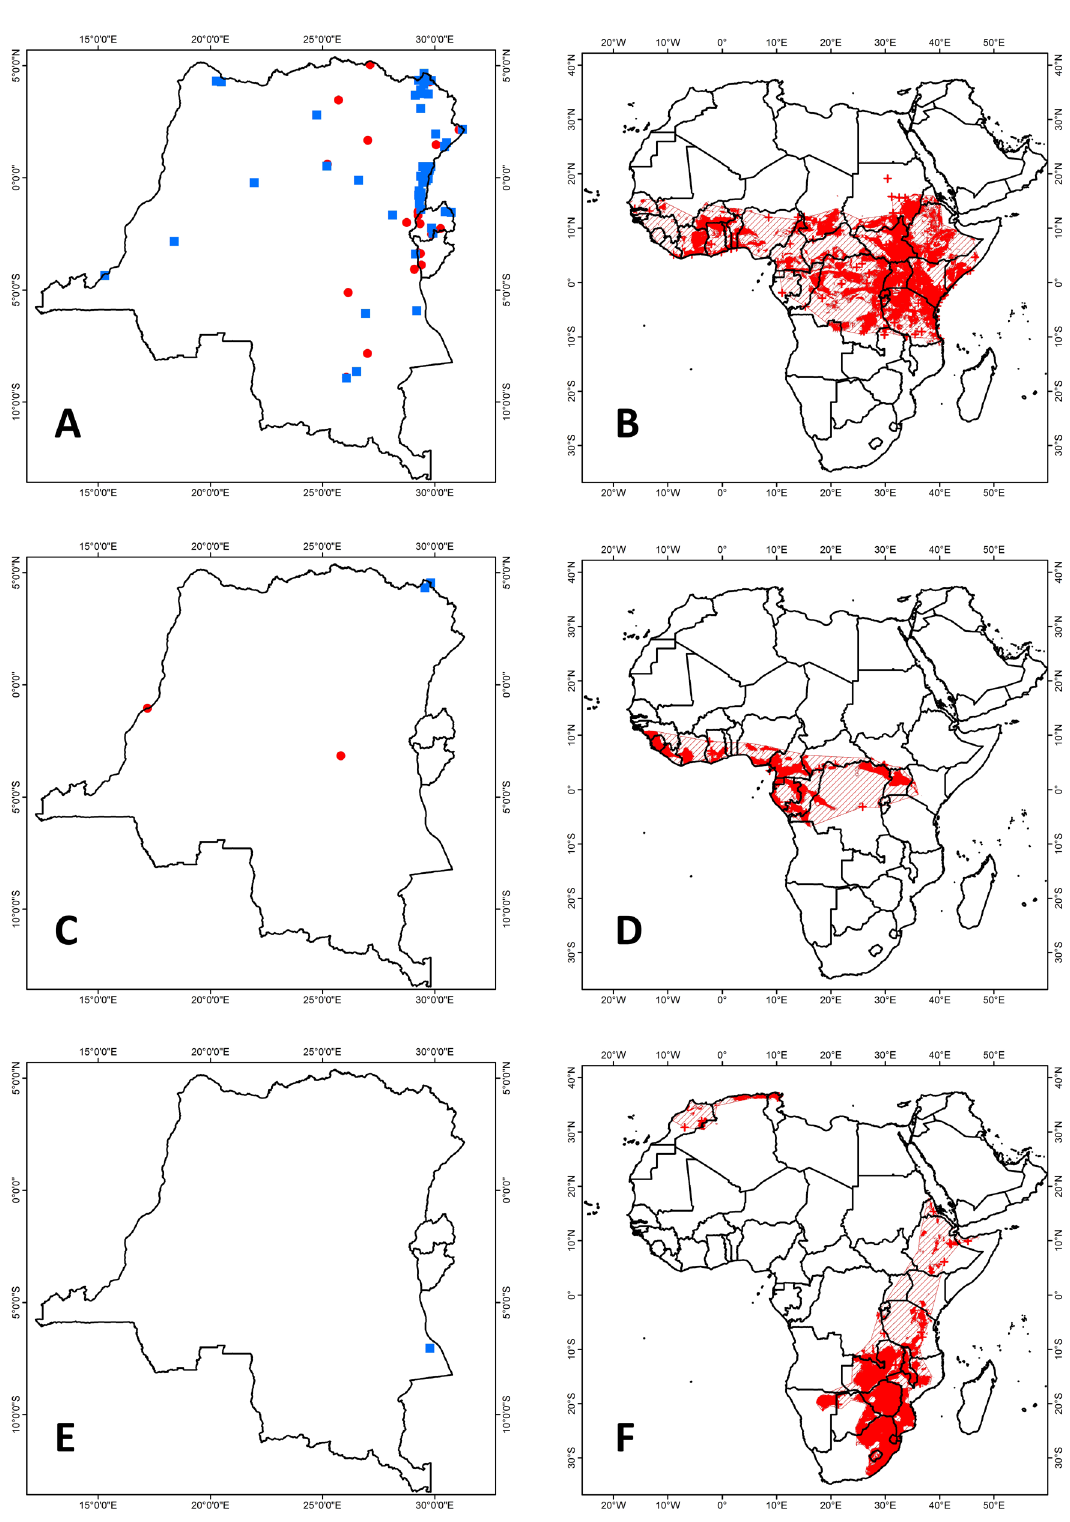
Fig. 14. Distribution maps. A–B . Lavia frons (E. Geoffroy St.-Hilaire, 1810). C–D . Rhinolophus